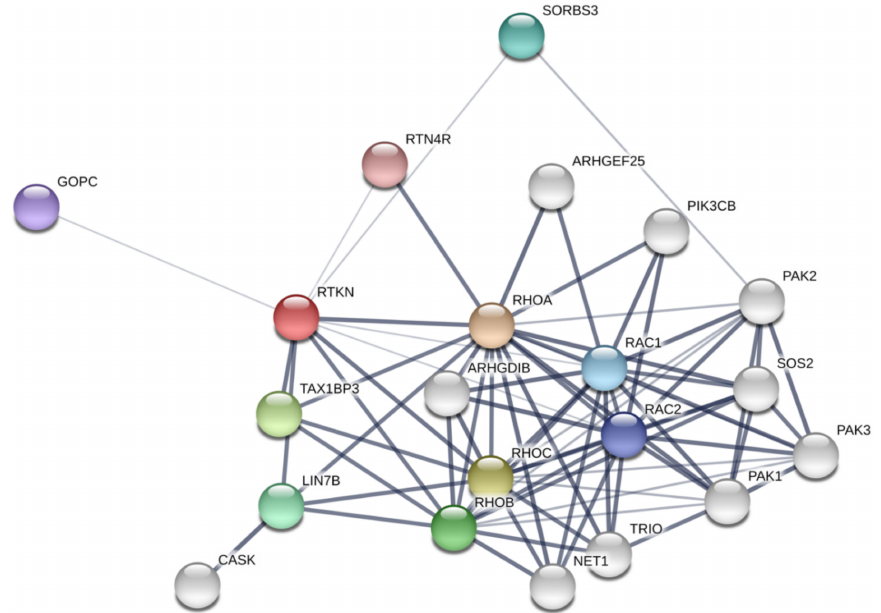
Figure 4. Rhotekin-interacting protein network analysis using STRING software. The thickness of the line indicates the strength of the interaction. Note that the interaction between Rhotekin (RTKN) and Rac has contradicted a previous report [6]. Colored nodes, the query protein and first shell of interactors; White nodes, second shell of